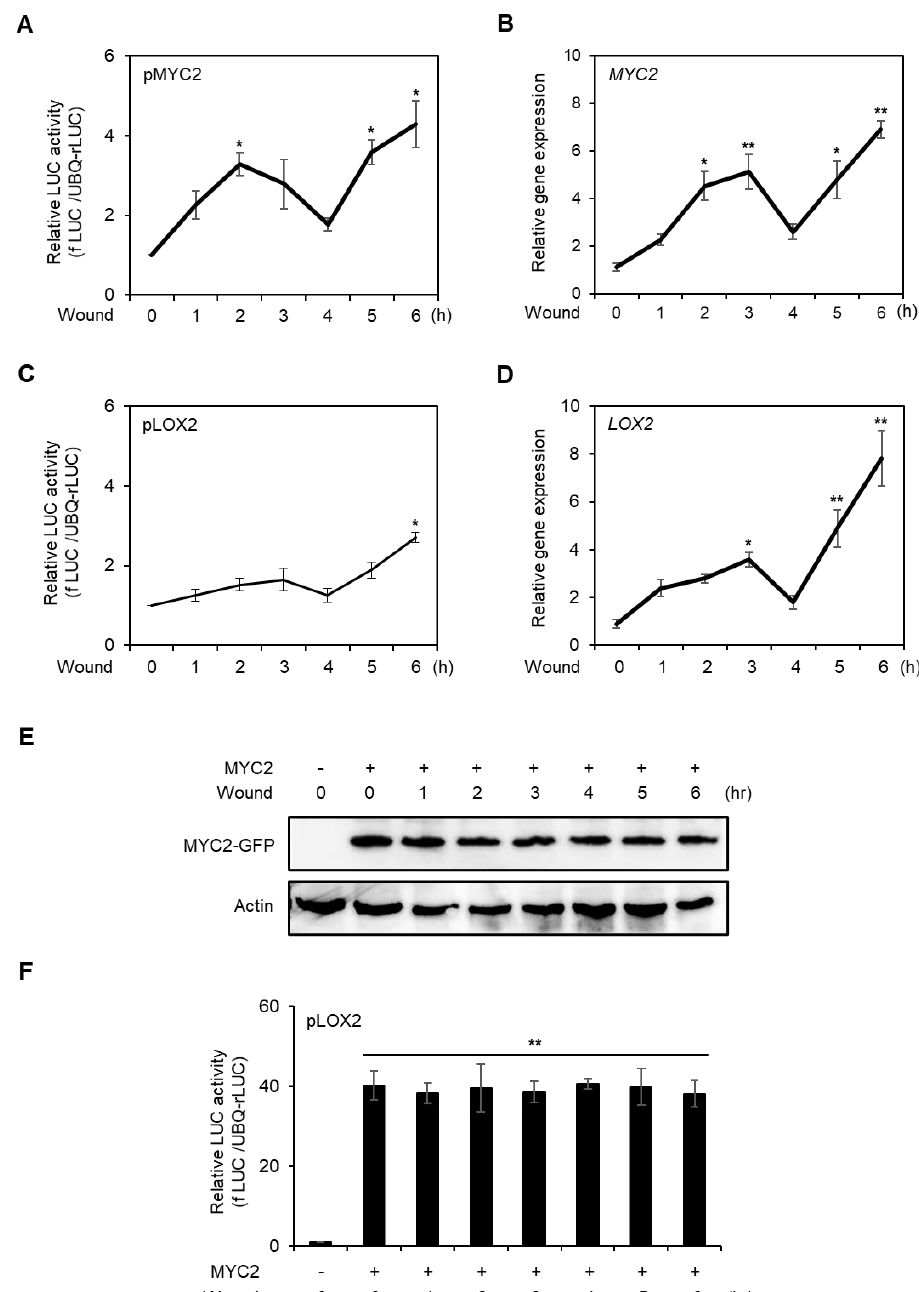
Figure 4. Analysis of promoter activity, gene expression, and protein stability of MYC2 in wounded protoplast at the late stage of wounding. Promoter activities of MYC2 ( A ) and LOX2 ( C ) in the late stage of wounded protoplast. fLUC- conjugated MYC2 and LOX2 promoters were respectively trans- fected to AMPs and incubated for 6 h. Vortex-induced wounding was generated in AMPS and in- cubated for 6 h. The promoter activities were determined in a time-dependent manner. UBQ - rLUC was used as an expression control. Values are means ± SE of three repeats: * p < 0.01. AMPs were incubated for 4 h without transfection and wounded by vortex and incubated for the designated time points. Total RNA was isolated from the AMPs and RT-qPCR was carried out with gene-spe- cific primers of MYC2 ( B ) and LOX2 ( D ). Actin2 was used as an expression control. Values are means ± SE of three repeats: * p < 0.01 and ** p < 0.001. ( E ) Analysis of MYC2 protein stability in wounded protoplasts. 35S promoter-driven C-terminal GFP- conjugated MYC2 was transfected and incubated for 10 h. The protoplasts were wounded and incubated for designated time points and harvested. MYC2 proteins were detected using an anti-GFP antibody. Actin was used as a loading control. ( F ) Transient promoter activity of LOX2 with MYC2 effector in wounded protoplast. fLUC- conjugated